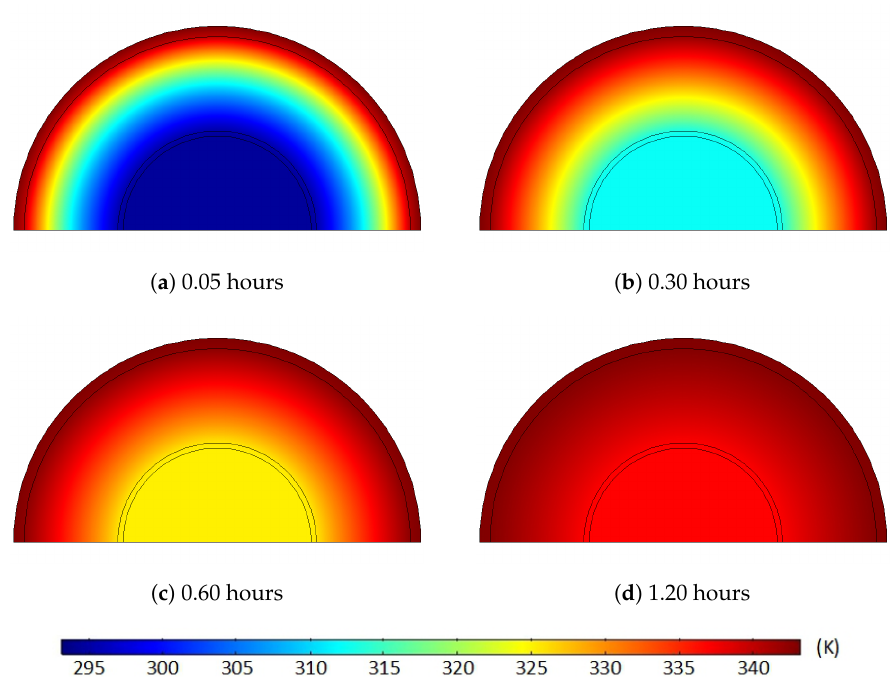
Figure 5. Temperature (K) of the cable at different degassing times where the target degassing chamber temperature is 343.15 K: ( a ) 0.05 hours, ( b ) 0.30 hours, ( c ) 0.60 hours, ( d ) 1.20